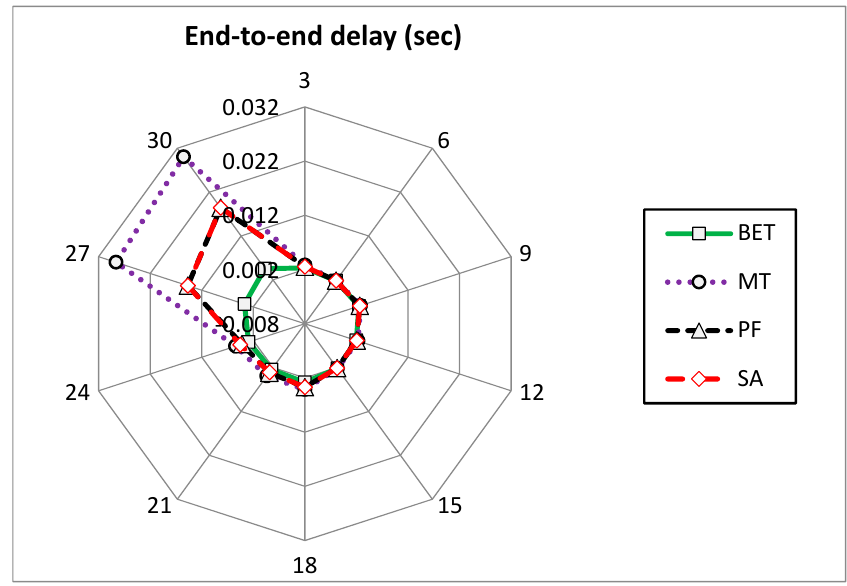
Figure 5. Average packet end-to-end delay results for cell-edge video users.